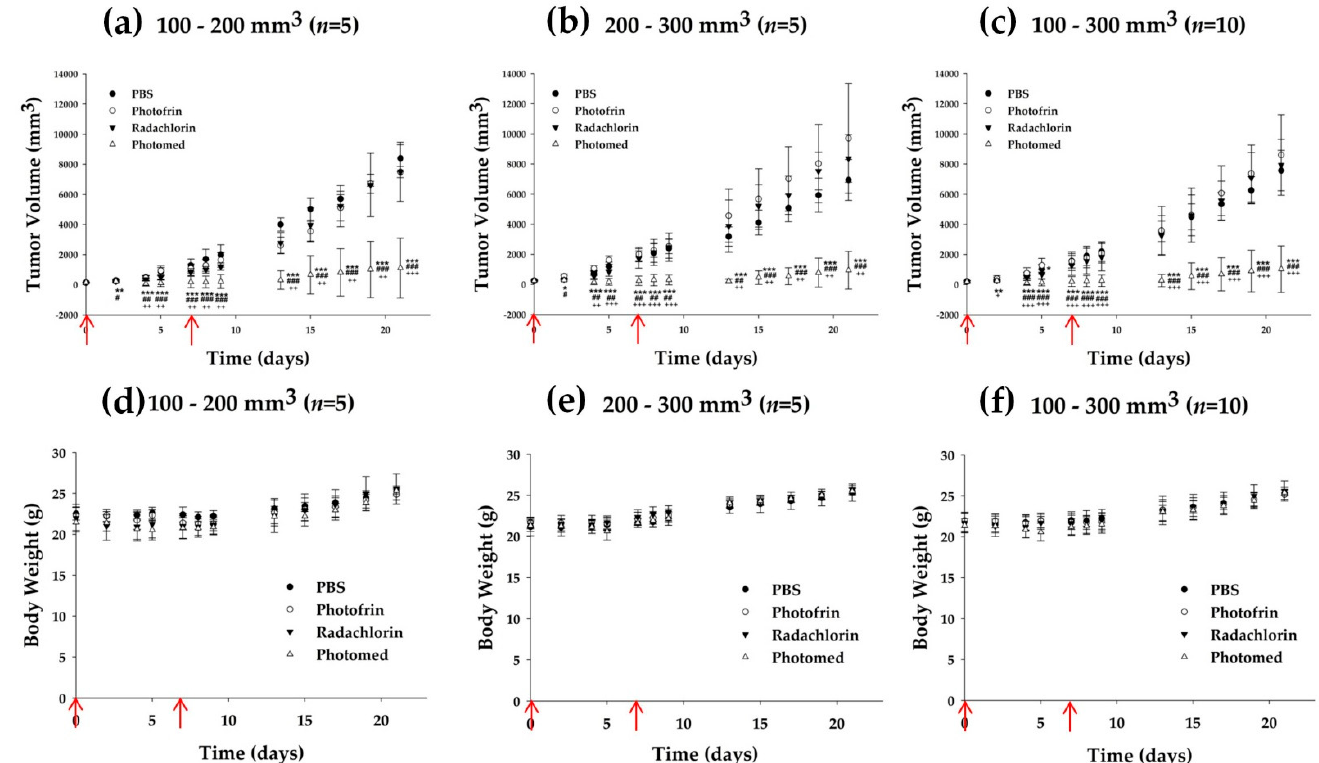
Figure 7. Tumor volume and body weight monitoring of SCC VII tumor-bearing mice after double (on days 0 and 7, red arrows) administration of PBS, Photofrin, Radachlorin and Photomed followed by light irradiation (400 mW/cm 2 , 500 s) (on days 0 and 7, red arrows) 3 h after each injection. ( a , d ) Small-tumor group (tumor size ranging from 100 to 200 mm 3 ) ( n = 5). ( b , e ) Large-tumor group (tumor size ranging from 200 to 300 mm 3 ) ( n = 5). ( c , f ) Small- and large-tumor combined group (tumor size ranging from 100 to 300 mm 3 ) ( n = 10). The tumor volume (mm 3 ) was calculated using the following formula; (length × width 2 )/2. Data are presented as means ± SD. * p < 0.05, ** p < 0.01, *** p < 0.001, PBS vs. Photomed. # p < 0.05, ## p < 0.01, ### p < 0.001, Radachlorin vs. Photomed. + p < 0.05, ++ p < 0.01, +++ p < 0.001, Photofrin vs. Photomed.